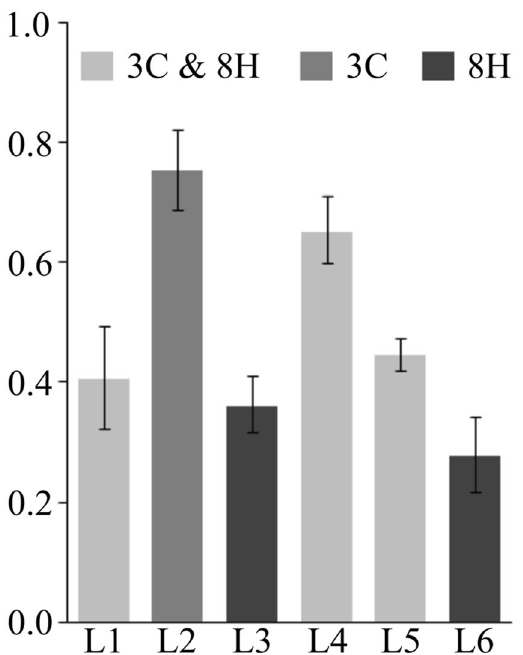
Figure 4. Average anisotropy factor ( β ) calculated for the ROIs in Fig. 2a with bars indicating the 99% confidence intervals. Based on non-overlapping confidence intervals, significant differences can be seen between the identified 3C and 8H SFs. However, the difference between 3C & 8H and 8H (more precisely between ROIs L1, L3 and L6) is not statistically